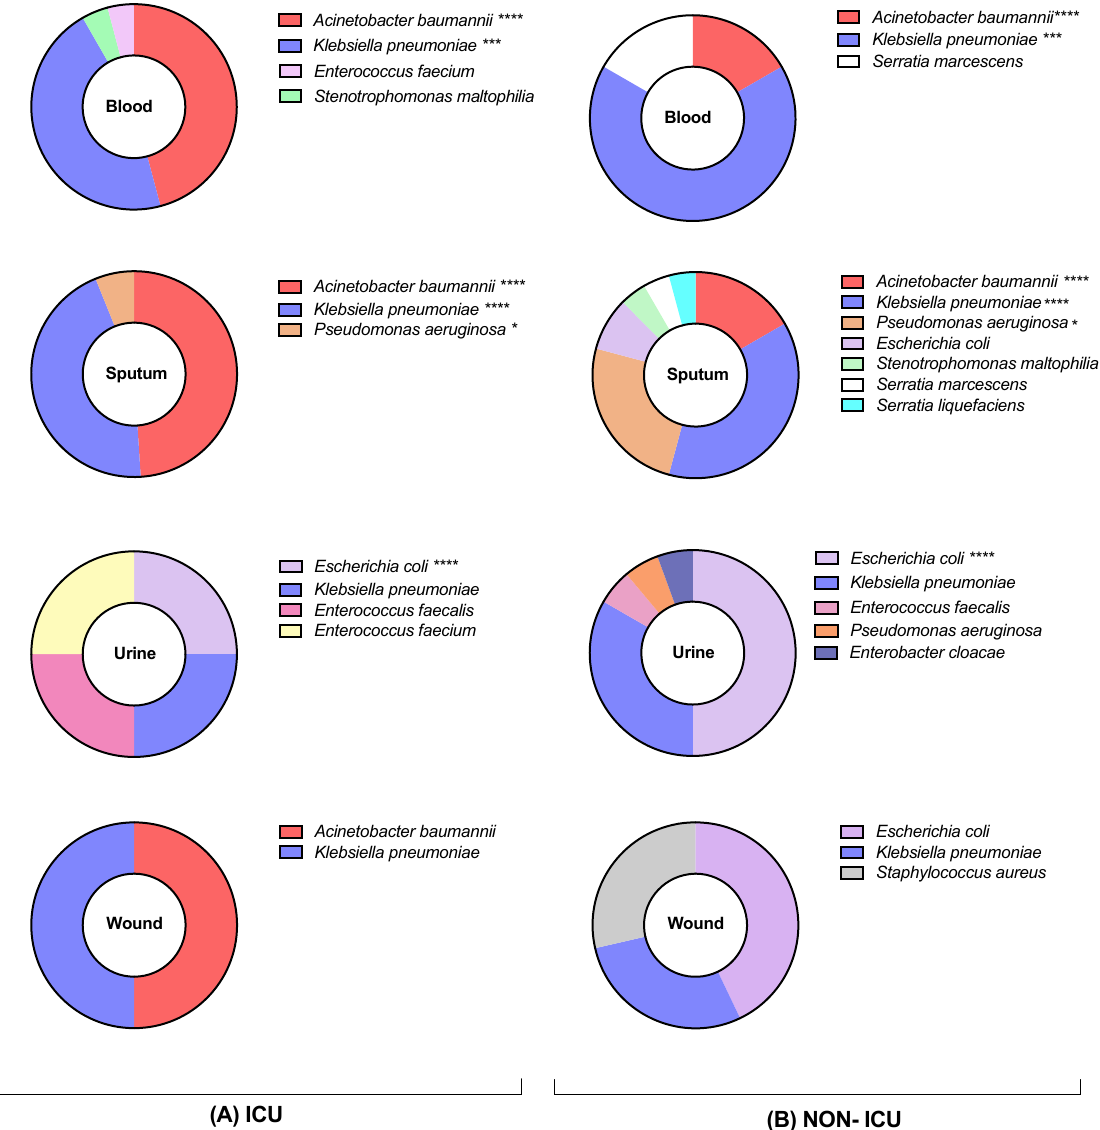
Figure 2. The numbers of identified bacterial species isolated from COVID-19 patients admitted to ( A ) ICU and ( B ) non-ICU in different sample types (blood, sputum, urine, and wound swabs); * p < 0.05, *** p < 0.001, **** p < 0.0001.